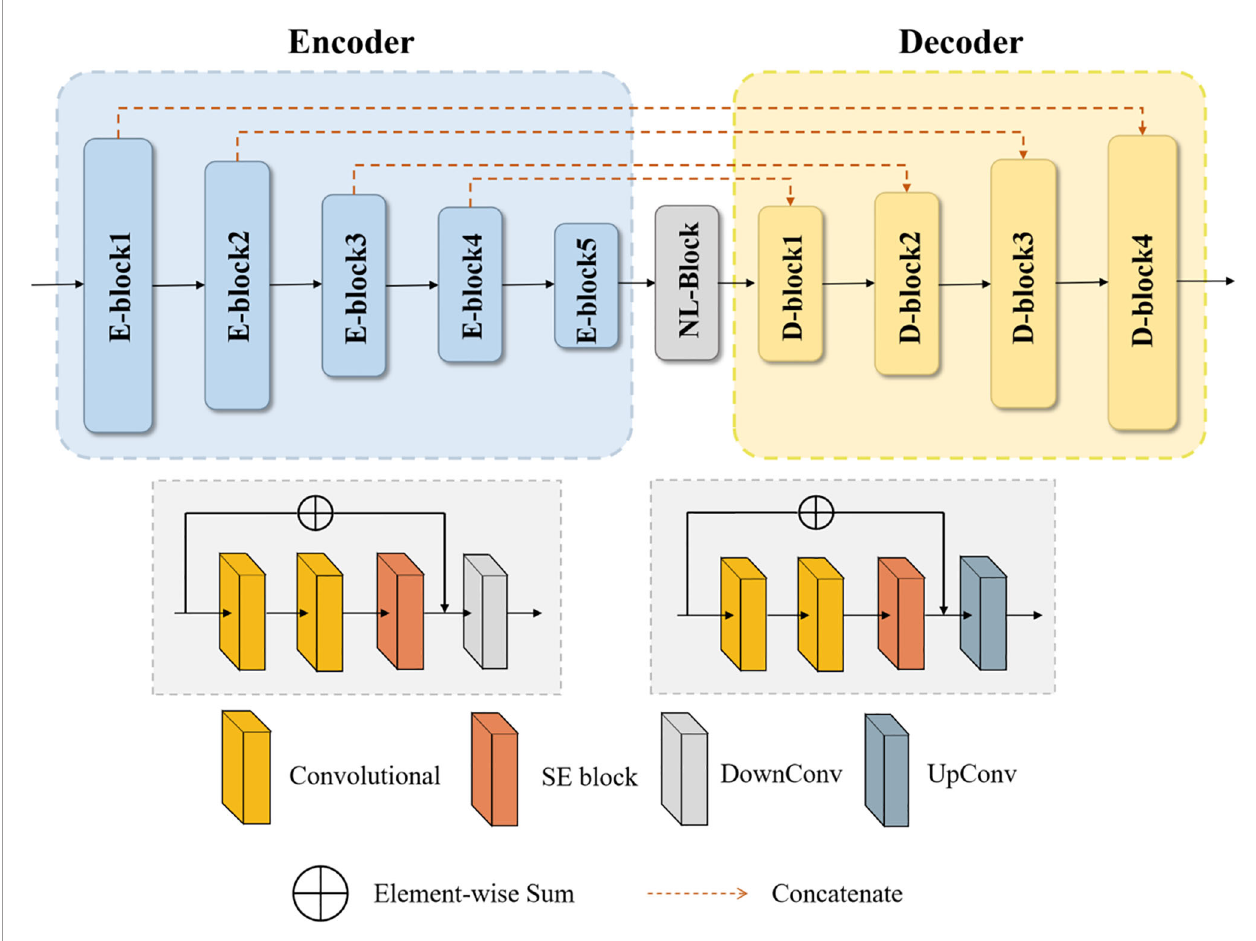
FIGURE 2 | Schematic diagram of the NLSE-VNet for the glioma